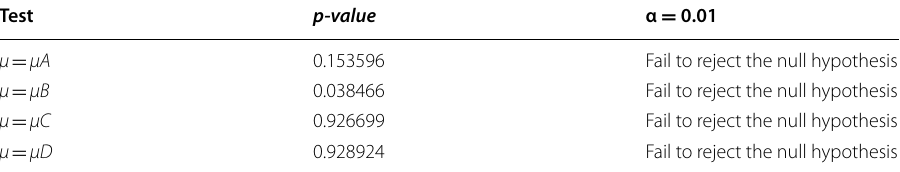
Table 10 T test: Statistical coherence of the initial dataset with A , B , C and